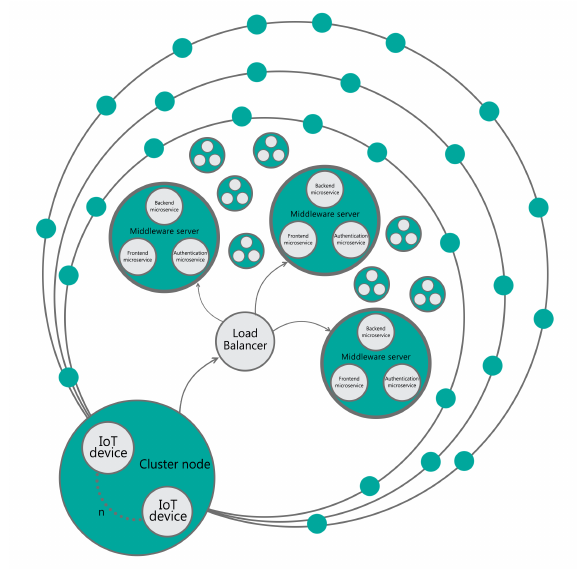
Figure 9. Testbed